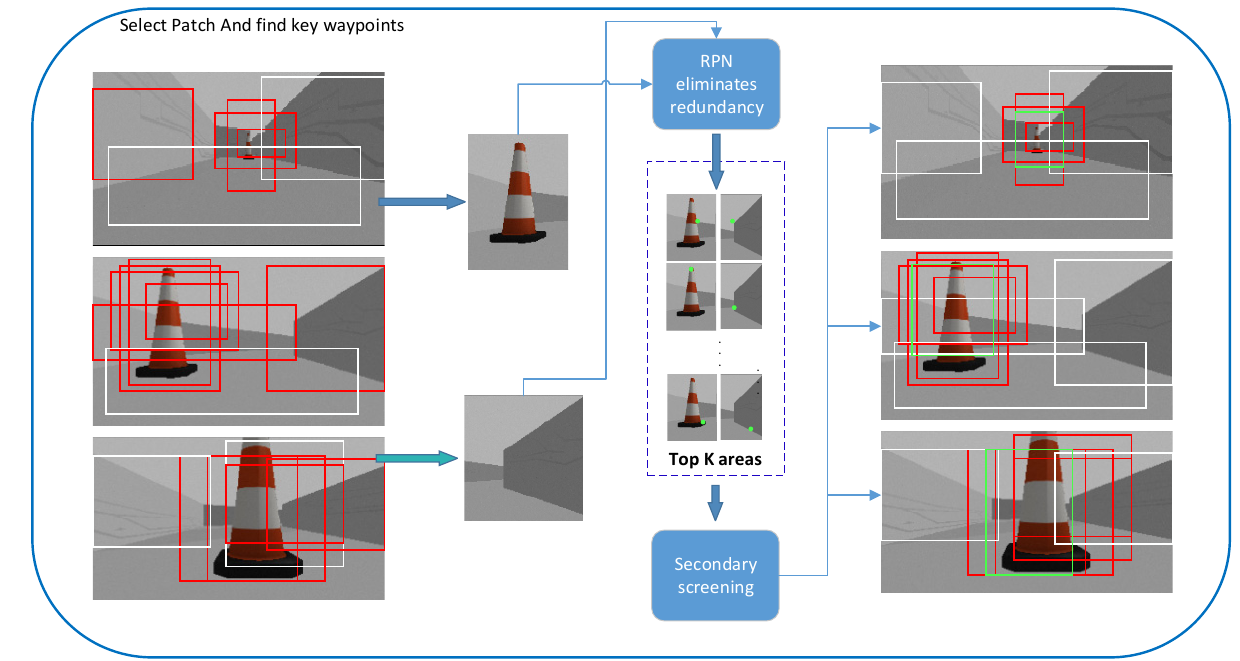
Figure 3. Illustration of the process to eliminate redundant points and obtain key waypoints. Algorithm 2 . Patch-based Selection and